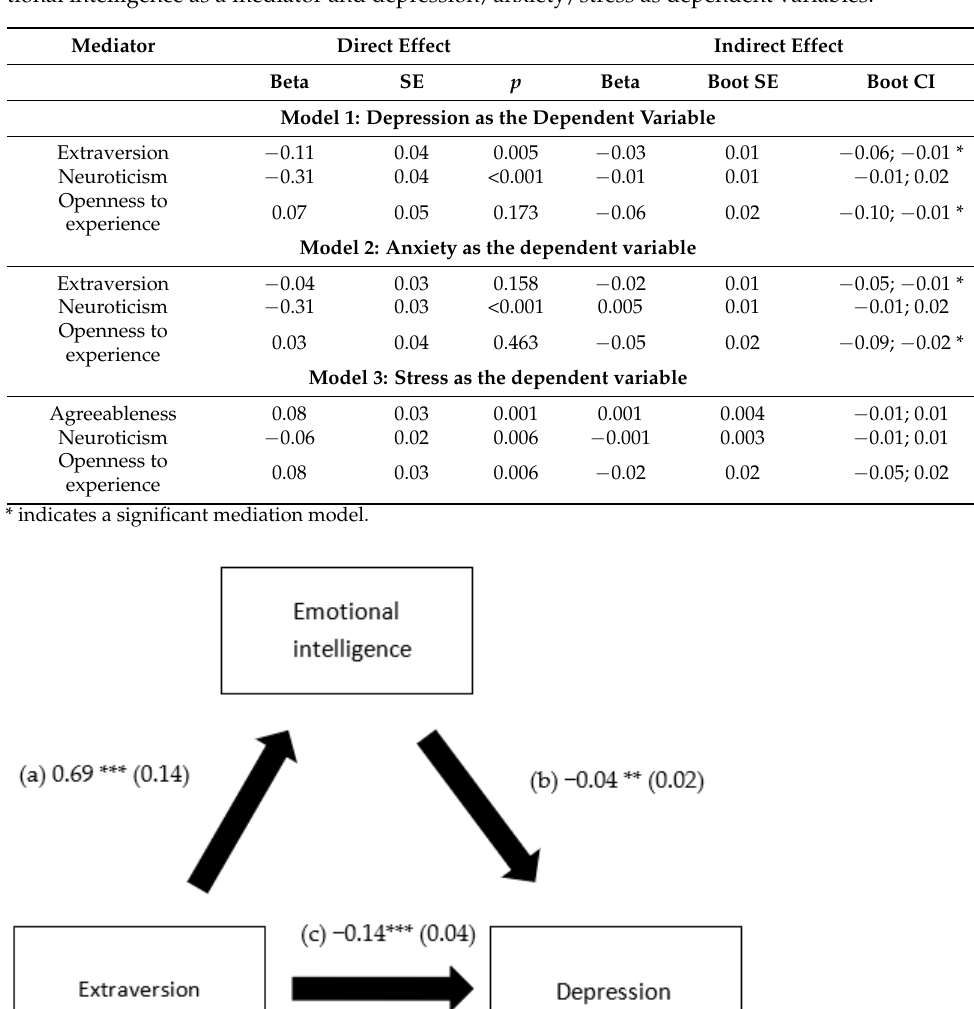
Table 5. Mediation analyses results, taking each personality trait as an independent variable, emo- tional intelligence as a mediator and depression/anxiety/stress as dependent variables.